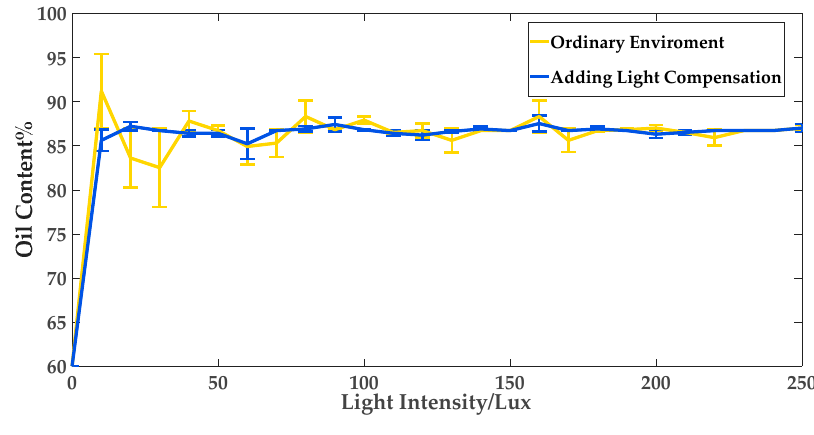
Figure 9. The effect of light compensation on test results. Table 1. Measurement accuracy comparisons with or without illumination compensation.